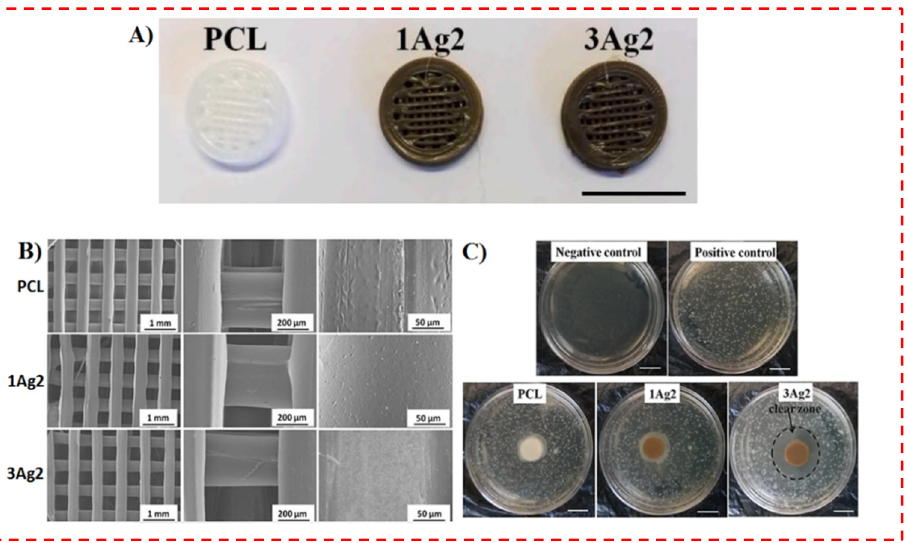
Figure 9. ( A ) Photograph of the 3D printed scaffolds (scale bar denotes 1 cm), ( B ) SEM image of 3D printed scaffolds, and ( C ) Soft agar plates inoculated with E. coli cells and incubated with 3D printed scaffolds in their center for 24 h (Scale bar denotes 1 cm) [37].